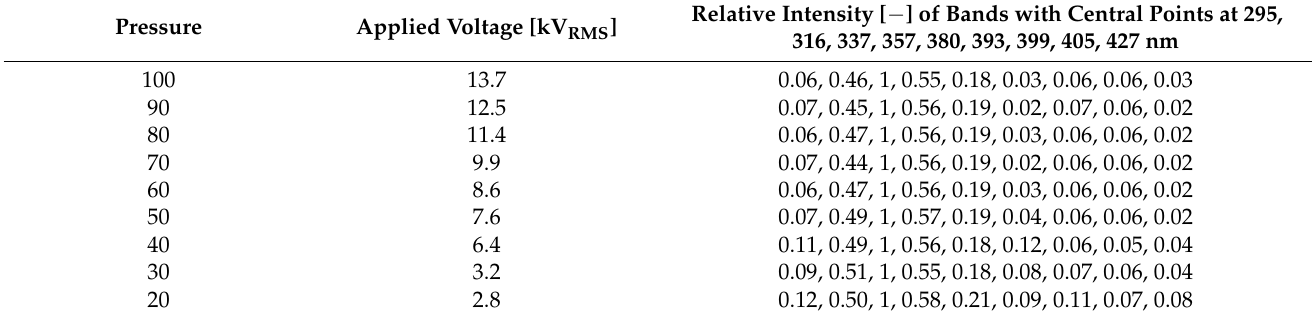
Table 2. Corona discharges. Experimental conditions using a needle-plane gap (diameter = 1.0 mm, gap = 30 mm), main spectral bands and their relative